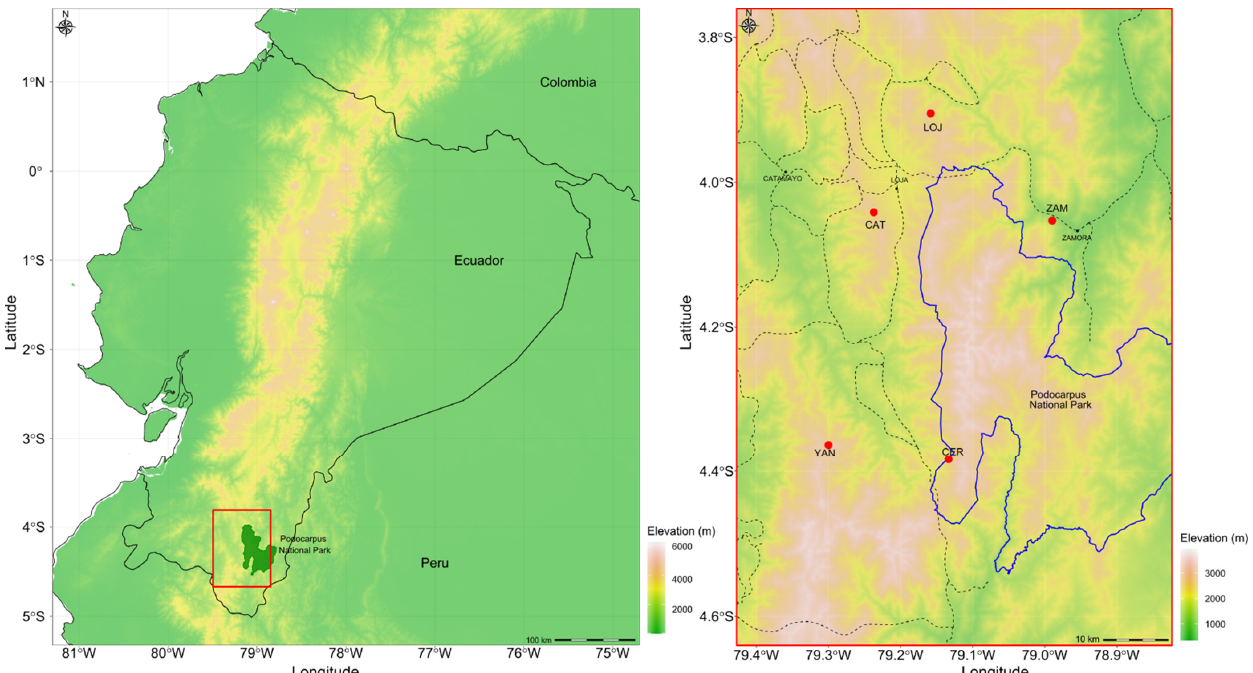
Figure 1. Topographic map of the study area in Ecuador with elevation displayed . Left: location of Ocotea rotundata populations and the Podocarpus National Park. Right: detail of the study area. Populations sampled are indicated by a red dot. Main roads are indicated by a dashed line. The blue line indicates the limit of the Podocarpus National Park. Main cities are also indicated.